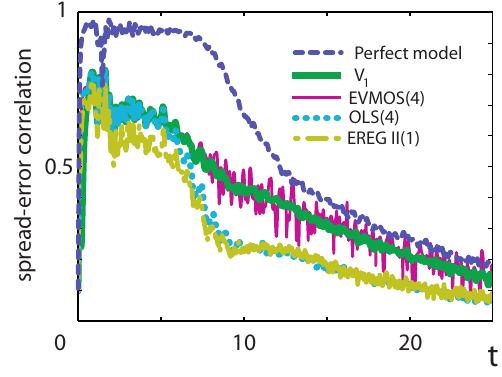
Fig. 12. The spread-error correlation against time for intermediate and long times. The spread is the square root of the ensemble variance and the error is the ensemble average of u r . The results are generated using the Lorenz model with large model error ( δr = 10 − 2 ) and averaged over 2 × 10 5 ensembles of 500 members each.